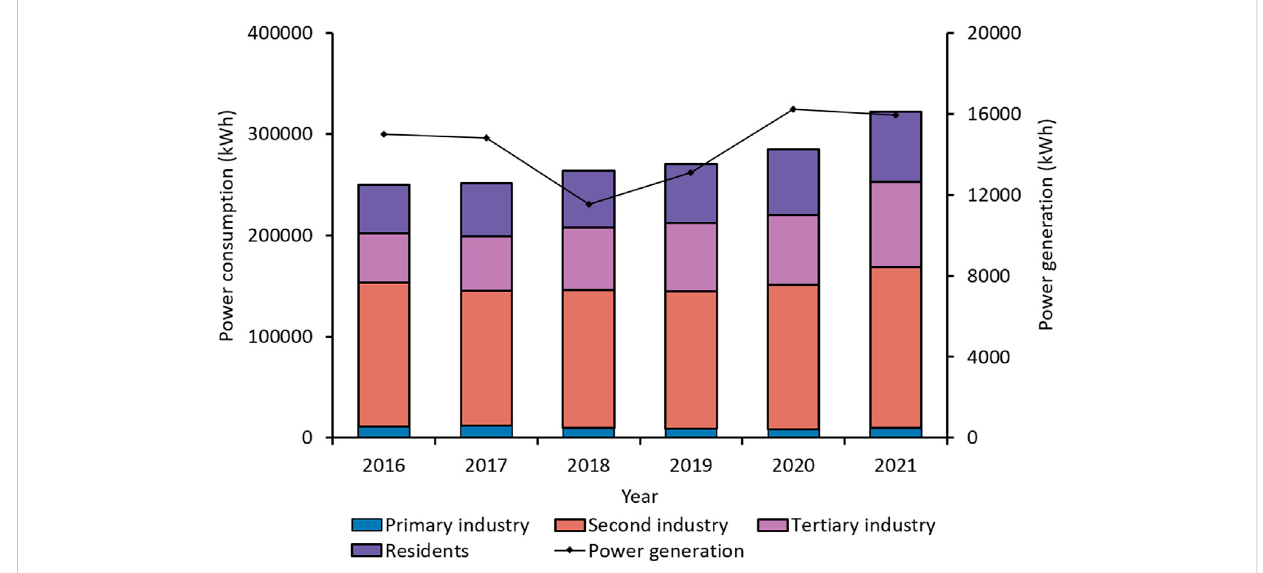
FIGURE 2 Power generation and consumption in Chongming from 2016 to 2021. Note: The power consumption is divided according to the primary industry, secondary industry, tertiary industry and urban and rural residents ’ living. Source: Chongming statistical yearbooks 2017 – 2022.